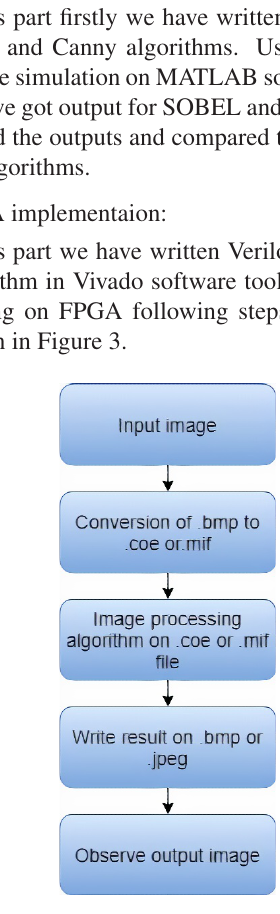
Figure 3. Processing of Image using